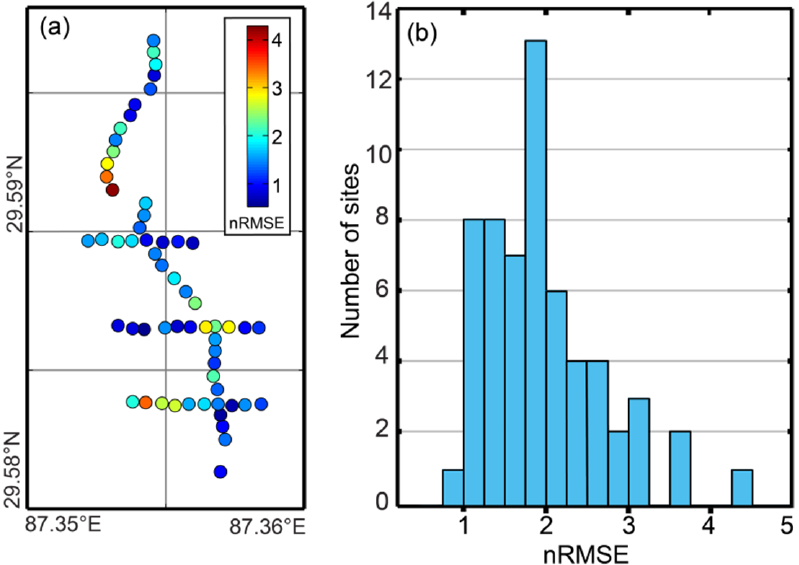
Figure 6. (a) Horizontal distribution of model misfits (nRMSE) of the 3D inversion with topography model for each AMT site. ( b ) Frequency histogram of site-by-site nRMSE.